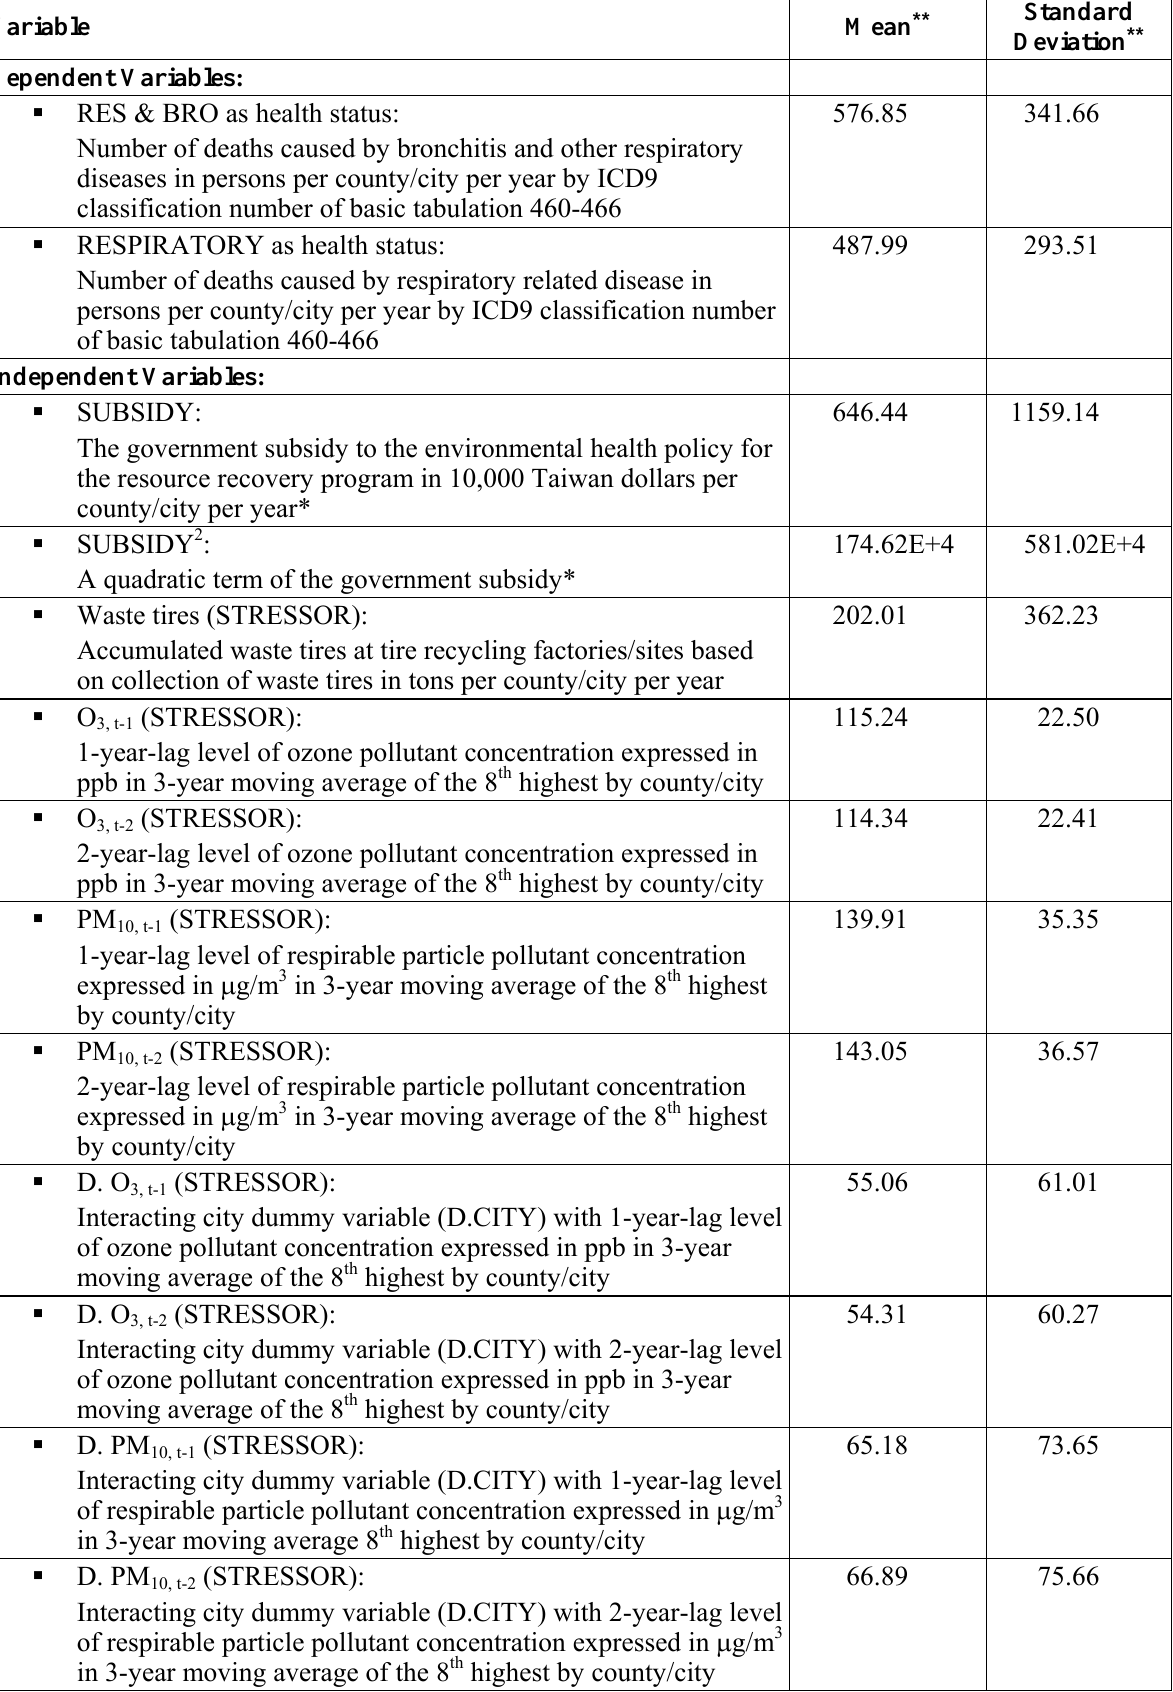
Table 1. Definition of Variables and their Descriptive